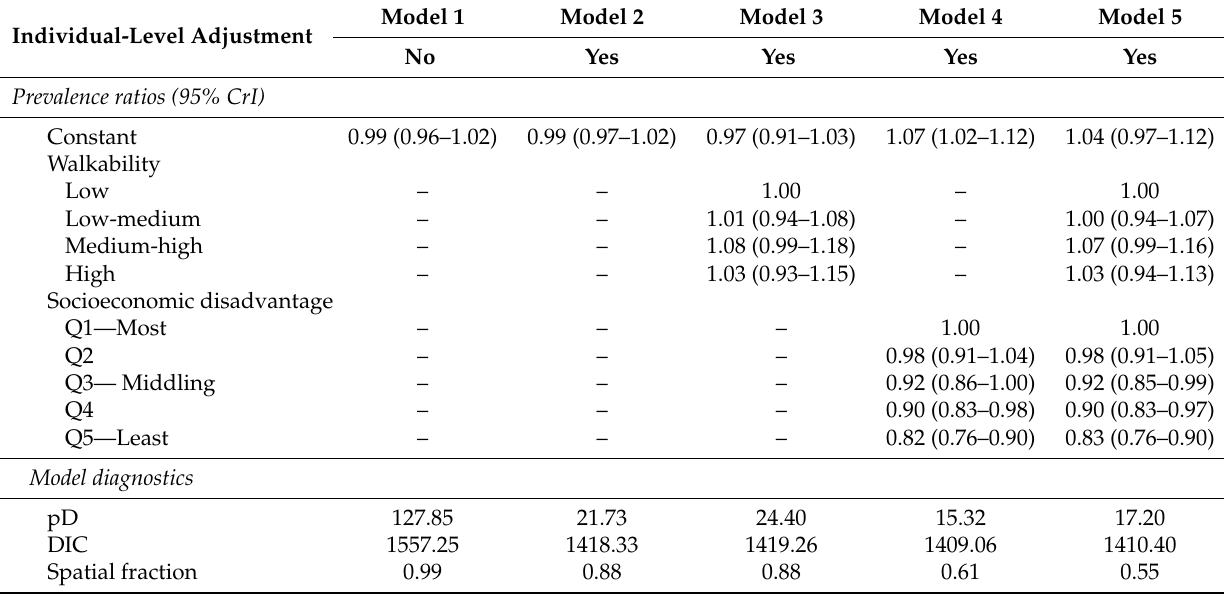
Table 2. Conditional auto regression model summaries for high psychosocial